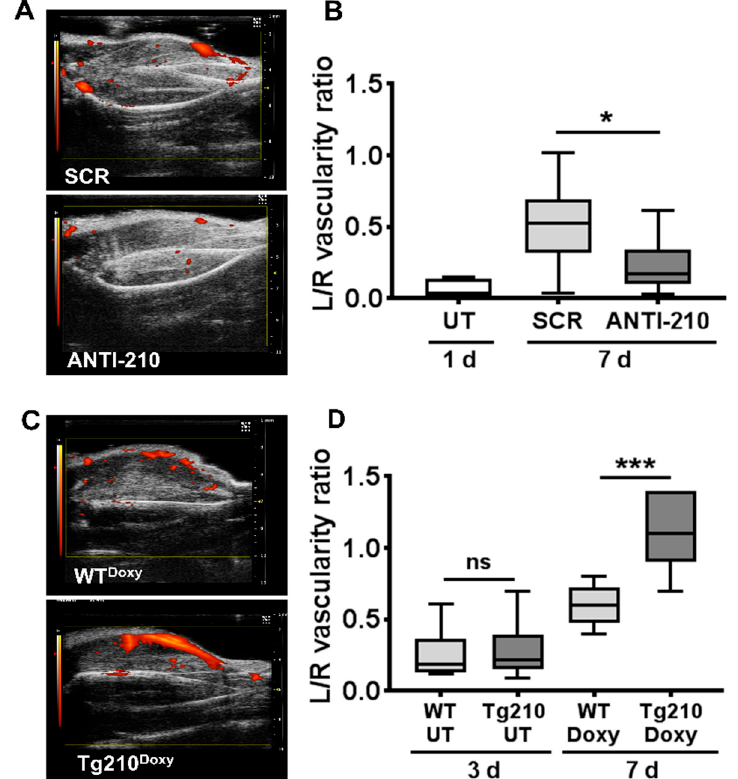
Figure 1. MiR-210 regulates blood flow recovery in vivo. Calf perfusion was monitored by ultrasound in power Doppler mode. Scale bar: 2 mm. ( A , C ) Representative images of the ischemic calf of the indicated groups taken at 7 days after ischemia; ( A ) scrambled (SCR) and ANTI-210, ( C ) Wild Type (WT) Doxy and Tg210 Doxy . ( B , D ) Box plots show perfusion, expressed as vascularity ratio; ( B ) untreated (UT) mice at day 1 and SCR and ANTI-210 treated mice 7 days after ischemia ( n = 7–9); ( D ) WT and Tg210 mice, either before miR-210 induction (untreated, UT), at 3 days after surgery or treated with doxycycline (Doxy) at day 7 of ischemia ( N = 5–6; for both panels, Anova multiple comparison * p < 0.04, *** p = 0.0008, ns = not significant).